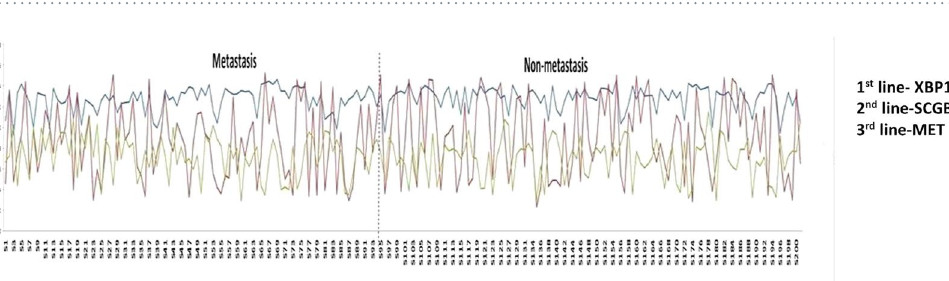
Figure 5. Expression patterns of genes in top three modules of non-metastasis stage.